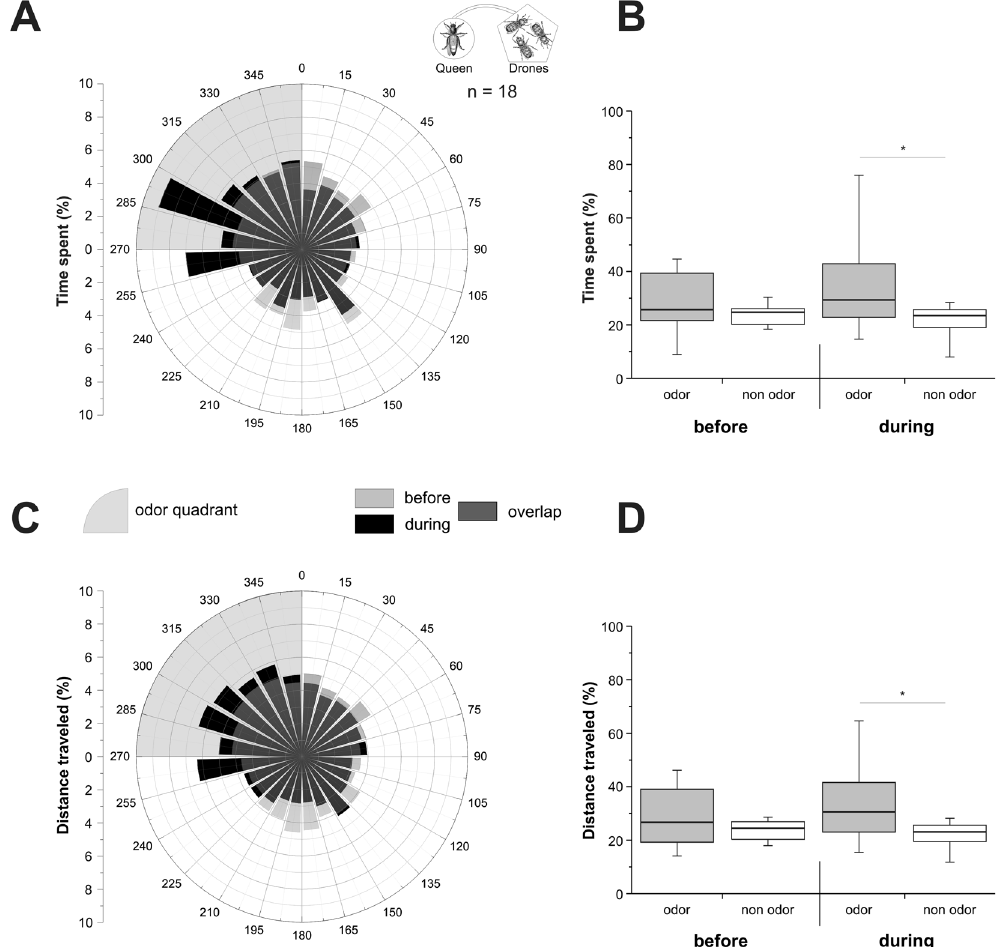
Figure 2. Experiment 1: virgin queens’ response to drone odour bouquet. Virgin queen’s behaviour on the walking simulator, when stimulated with the odour bouquet of 10 drones. ( A , C ) Circular histograms showing the percentage of time spent ( A ) or of distance travelled ( C ) by virgin queens according to 15° sectors, with the odour quadrant being represented on the upper left (grey area). Light grey bars represent the 5 min before odour stimulation (‘before’), black bars represent the 5 min during stimulation (‘during’), and hence, dark grey bars show the overlap of the two phases. ( B , D) Histograms of the percentage of time spent ( B ), or of distance travelled ( D ) by virgin queens in the odour quadrant (gray box) and on average in the three odourless quadrants (white box) before and during odour stimulation. * p < 0.05, Wilcoxon matched pairs